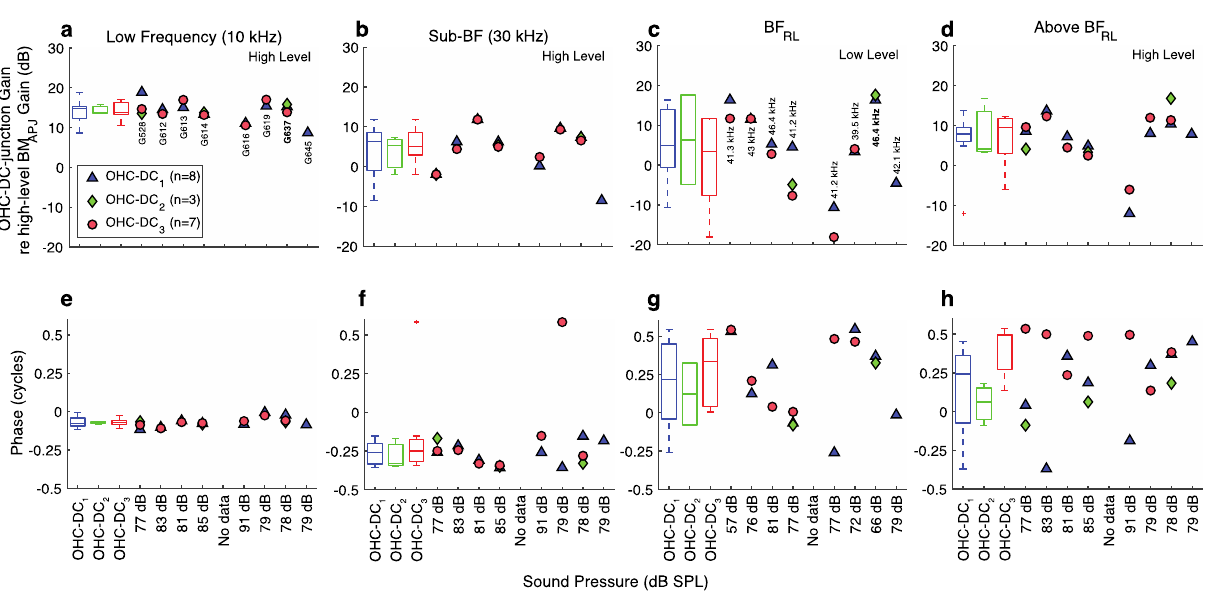
Figure 7. Summary comparisons of the in vivo normalized OHC-DC-junction gains at the basal ends of the OHCs, across animals, for the three OHC rows (OHC-DC 3,2,1 ). ( a – h ) The normalized-gain magnitudes ( a – d ) and corresponding phases ( e – h ), each with respective box-and-whisker-plot summaries, using the same frequencies and methods described in Fig. 5. The ANOVA p -values are all insignificant in this